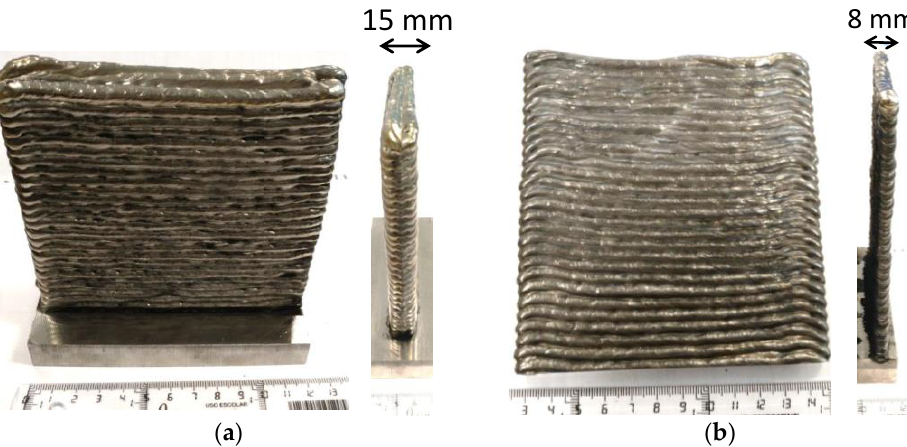
Figure 4. Manufactured WAAM walls: ( a ) Three weld beads per layer strategy, ( b ) single weld bead per layer strategy.